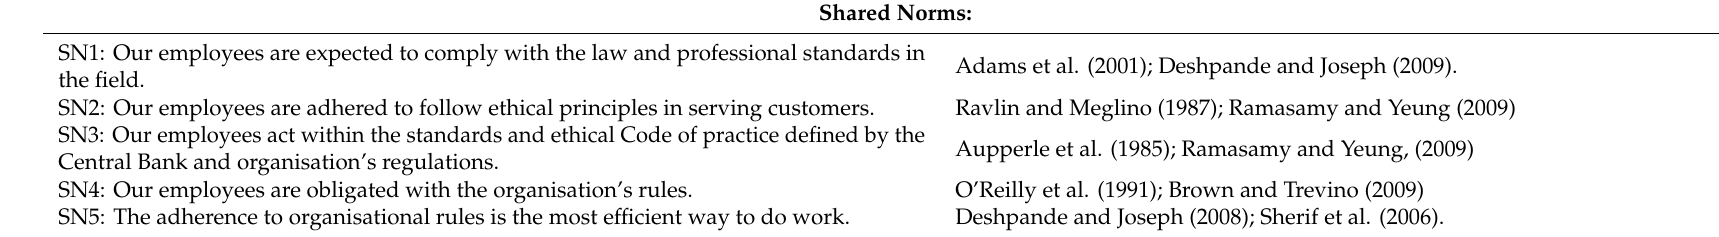
Table A2. Cont. Shared Norms: